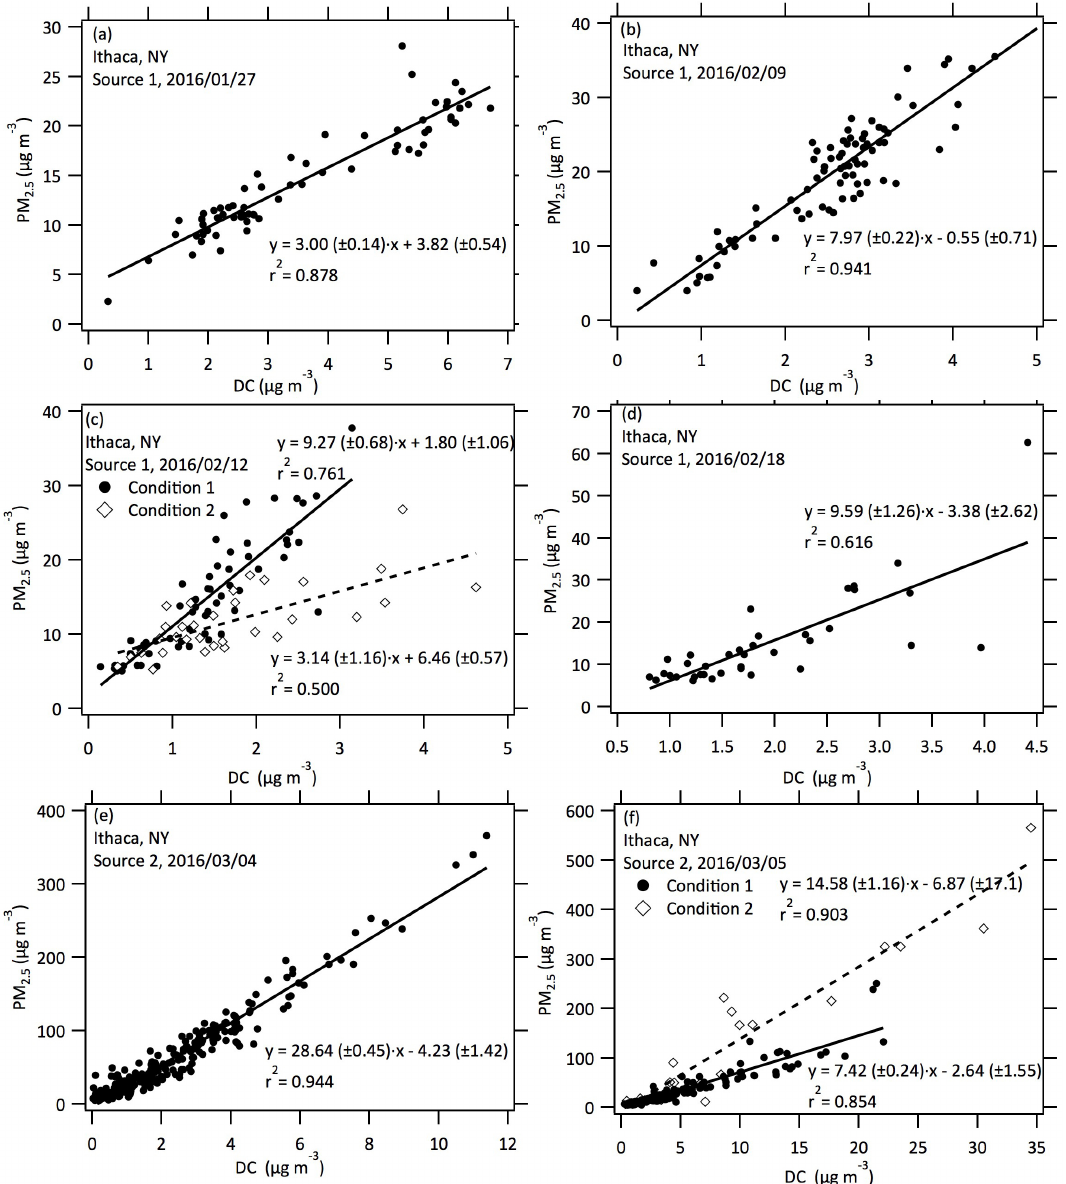
Figure 7. PM 2 . 5 vs. DC relationships from two reoccurring woodsmoke sources based on the plume measurements conducted in Ithaca, NY. Data are reported as 5-second averages. The dates are expressed in YYYY/MM/DD. The values inside the parentheses represent the corresponding one standard deviation.